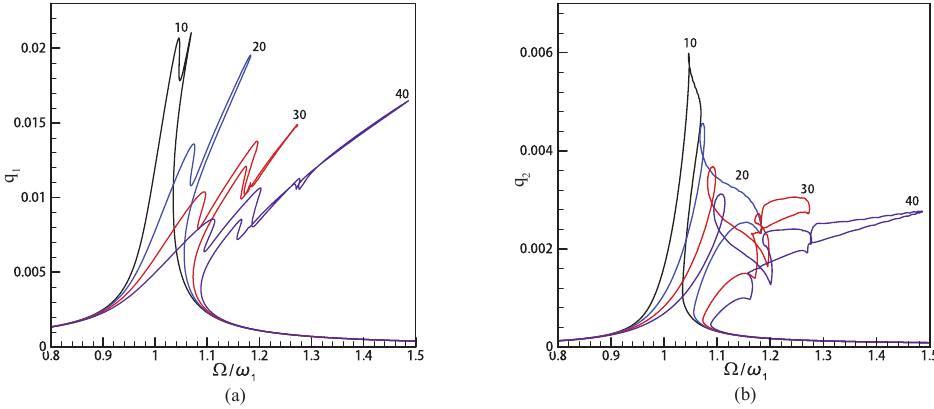
Fig. 5. The frequency response curve of the system with a three-to-one internal resonance between the first two modes: in the (a) first and (b) second generalized coordinates for several nonlinearity coefficients v 1 . The values of v 1 are denoted on the curves. bifurcation points are observed: (1) a limit point bifurcation at Ω = 1 . 1032 ω 1 ; (2) a limit point bifurcation